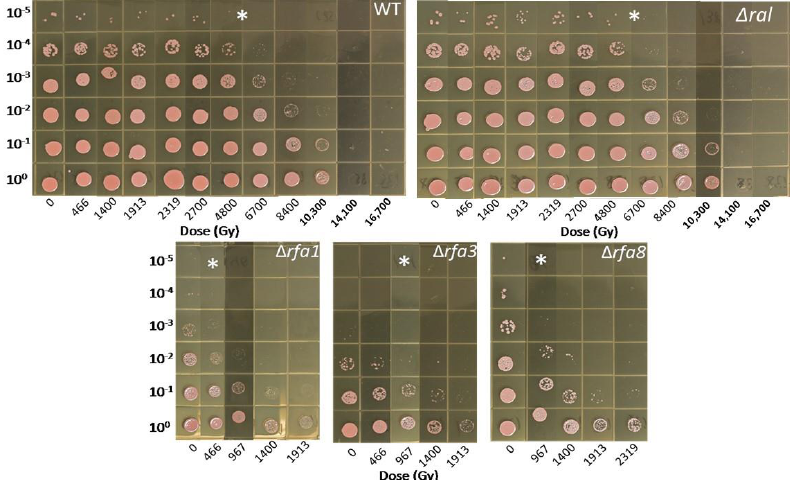
Figure 4. Survival of Hbt. salinarum strains to Ionizing radiation exposure. LH101 (WT), LH138 ( ∆ ral ), LH140 ( ∆ rfa1 ), LH134 ( ∆ rfa3 ), and LH136 ( ∆ rfa8 ) were exposed to increasing doses of electron beam radiation. * indicates dose at which each strain reaches the approximate D 10 . LH110 ( ∆ rfa5 ), LH142 ( ∆ rfa6 ), and LH128 ( ∆ yhcR ) showed wild-type survival and are not